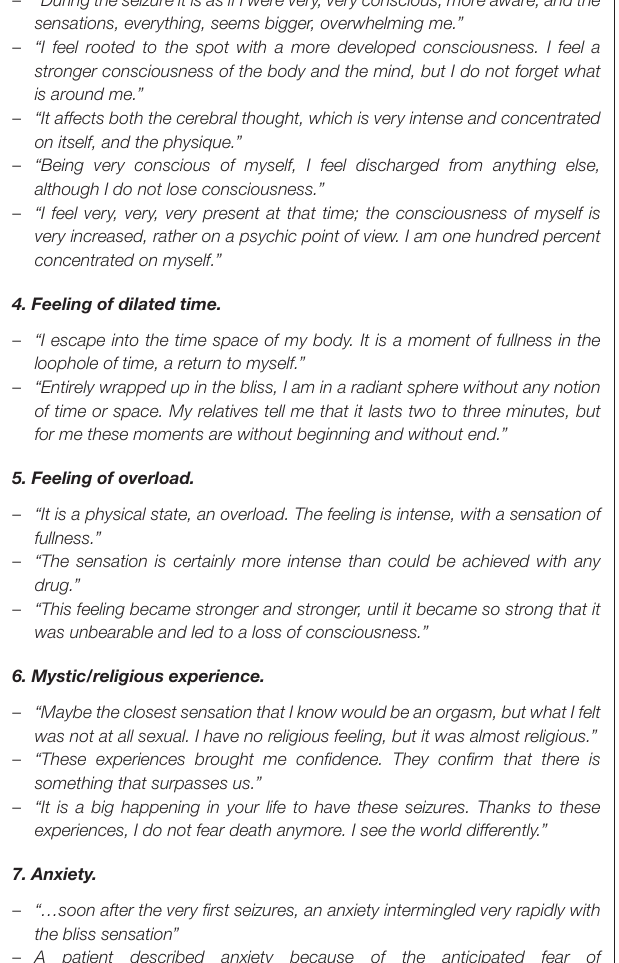
FIGURE 1 | Fyodor Dostoevsky, 1871 1